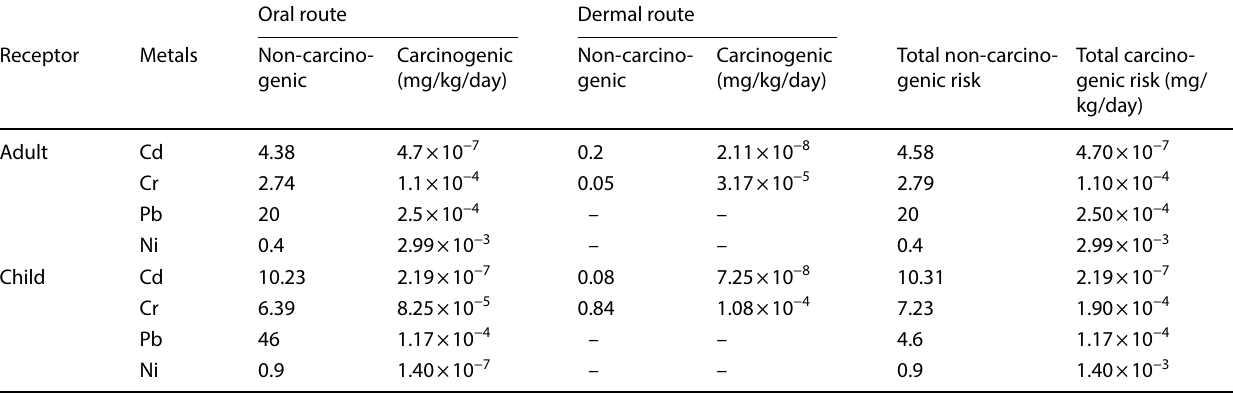
Table 7 Calculated non-carcinogenic and carcinogenic risk